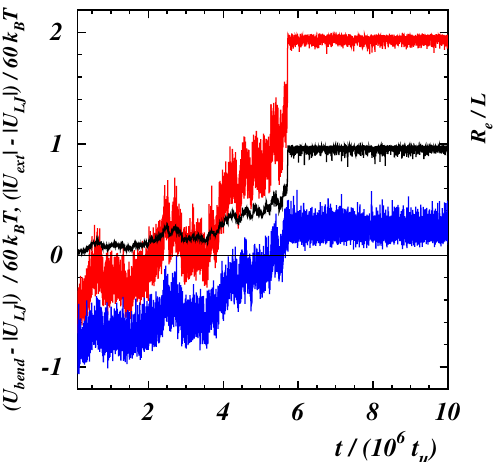
Figure 6. Potential energy differences U bend − | U LJ | (blue line) and | U ext | − | U LJ | (red line) as functions of time in the case of the polymer with L p / L = 0.8 and (cid:101) / ( k B T ) = 2 for F 2 = NFL p / ( k B T ) = 200. The time behavior of the end-to-end distance R e is also shown (black line).